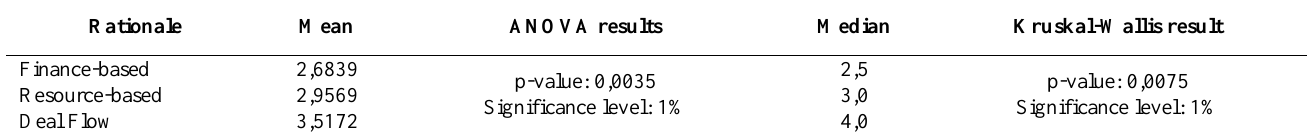
Table 7: Joint tests for differences in the non-syndication composite rationale variables